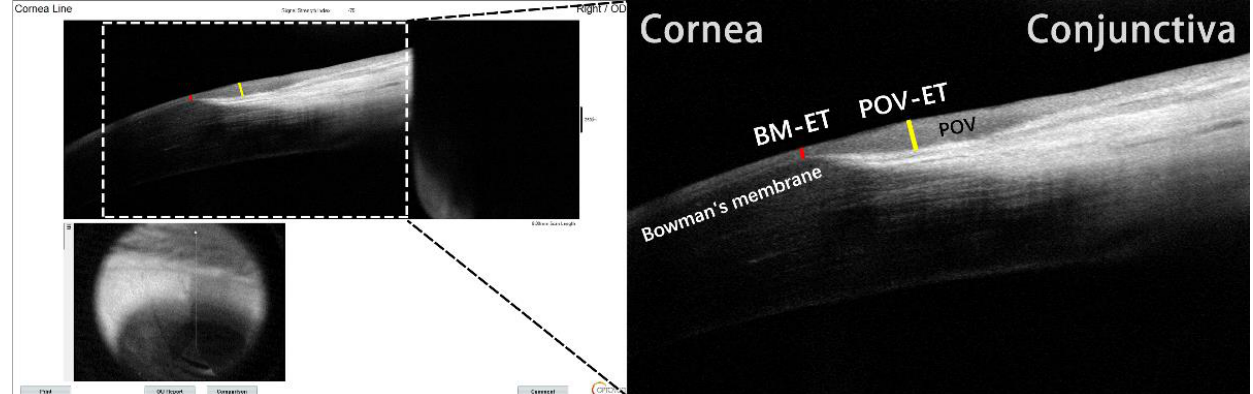
Figure 1. A diagram depicting the measurement of Bowman ’ s membrane epithelial thickness (BM- ET) and palisades of Vogt epithelial thickness (POV-ET). Red and yellow lines indicate BM-ET and POV-ET, respectively.